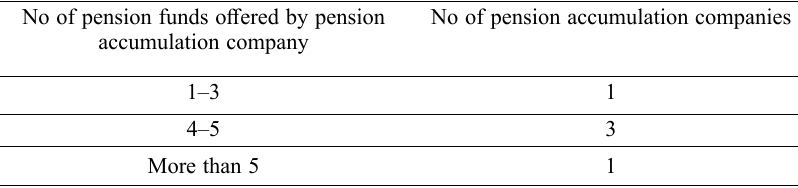
Table 6. Breakdown of supply of second pillar accumulation companies in Estonia No of pension funds offered by pension No of pension accumulation accumulation company